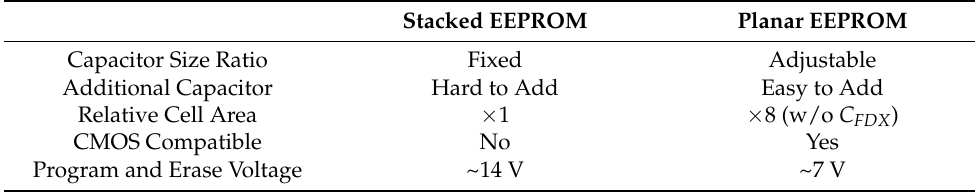
Table 3. Comparison of stacked and planar